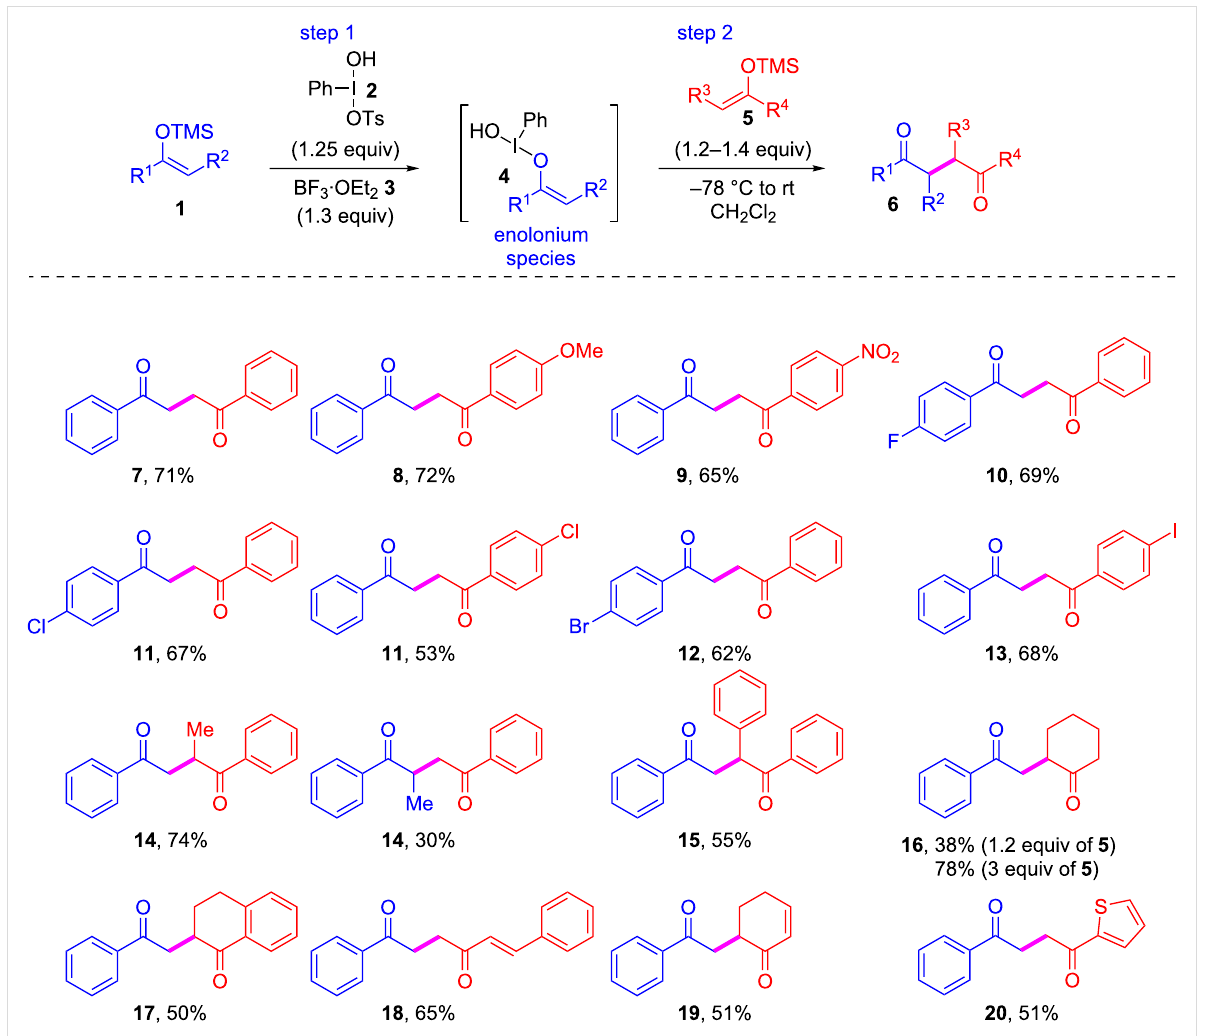
Scheme 2: Scope of the homo- and heterocoupling of enolates. The purple bond indicates the bond formed. The blue-colored fragments indicate the first TMS enol ether used to produce the electrophilic enolonium species 4 and the red fragments indicate the second TMS enol ether used as nucleo- phile 5 . All yields are isolated